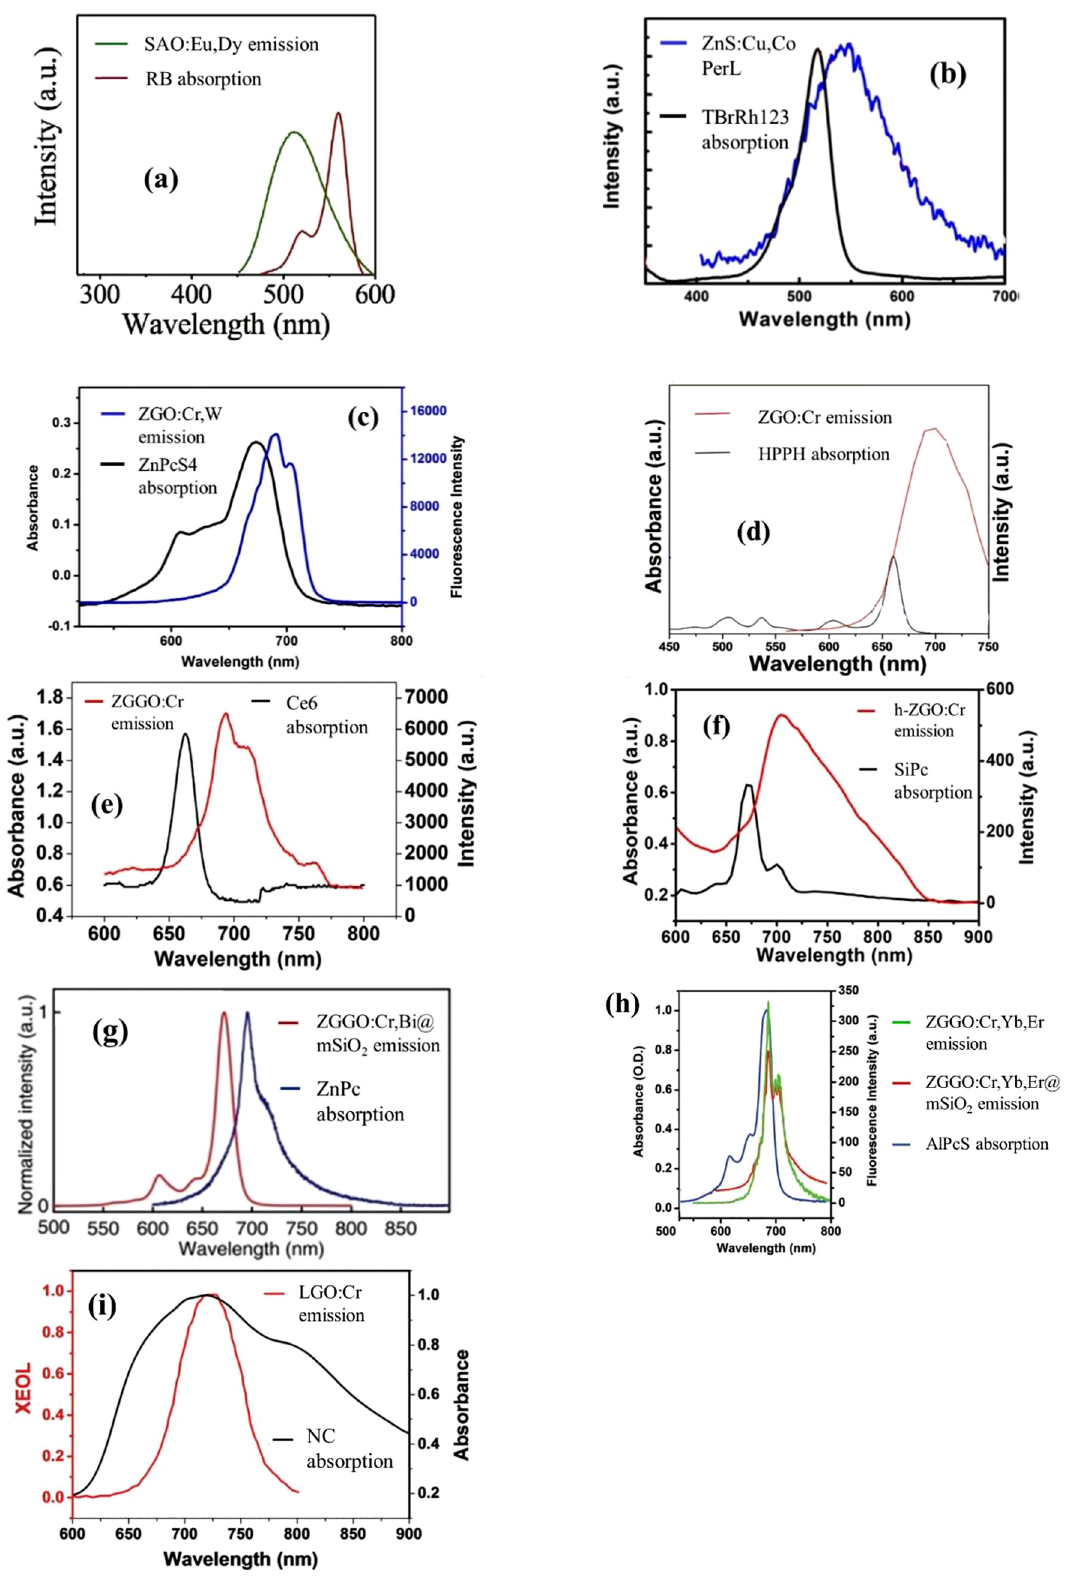
Figure 4: PerL materials emission spectra in correspondence to PSs absorption spectra in several examples of PerL-mediated PDT. The PerL material/PS couples are: (a) SAO:Eu,Dy/RB [144] (b) ZnS:Cu,Co/TBrRh123 [145] (c) ZGO:Cr,W/ZnPcS4 [146] (d) ZGO:Cr/HPPH [147] (e) ZGGO:Cr/Ce6 [148] (f) h-ZGO:Cr/SiPc [149] (g) ZGGO:Cr,Bi@mSiO 2 /ZnPc [150] (h) ZGGO:Cr,Yb,Er/AlPcS [151] (i) LGO:Cr/NC [152]. Reproduced with permissions from [144 –